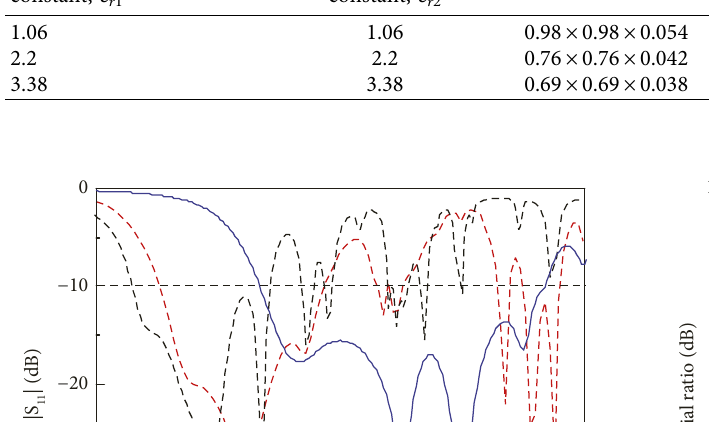
Table 1: Performance summary of the antenna with the same dielectric constants for both the lower and upper substrates. Lower substrate dielectric